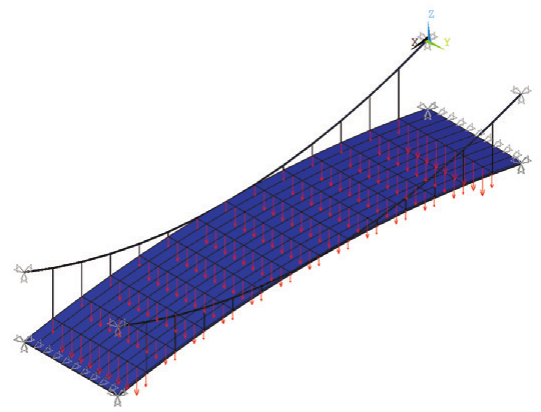
Fig. 10. 3D numerical model of the structure, where plywood boards are placed without the clearances and the deck behaves in compression in longitudinal direction and in bending in transversal direction